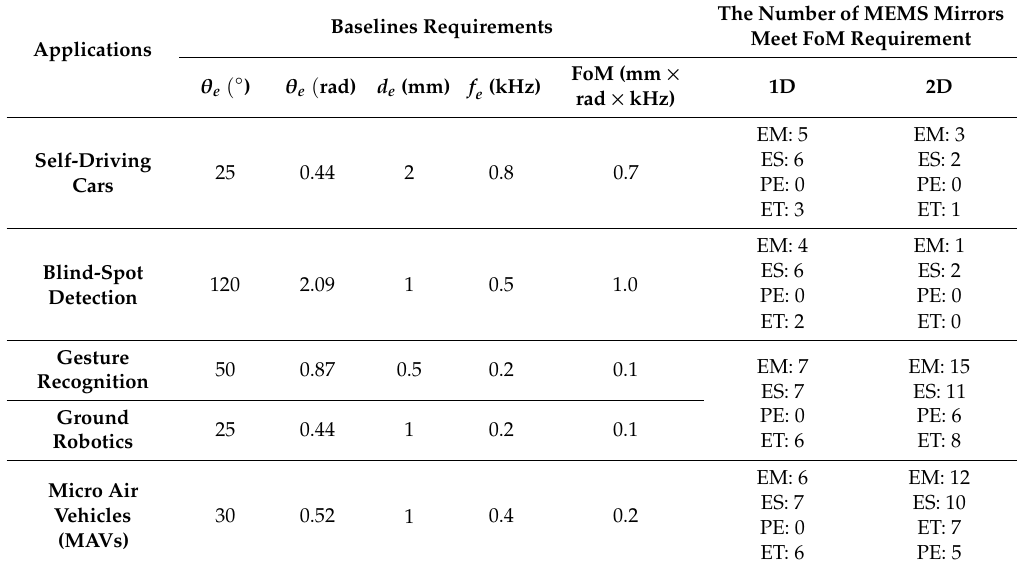
Table 7. The minimum requirements and FoMs for MEMS mirrors for di ff erent LiDAR